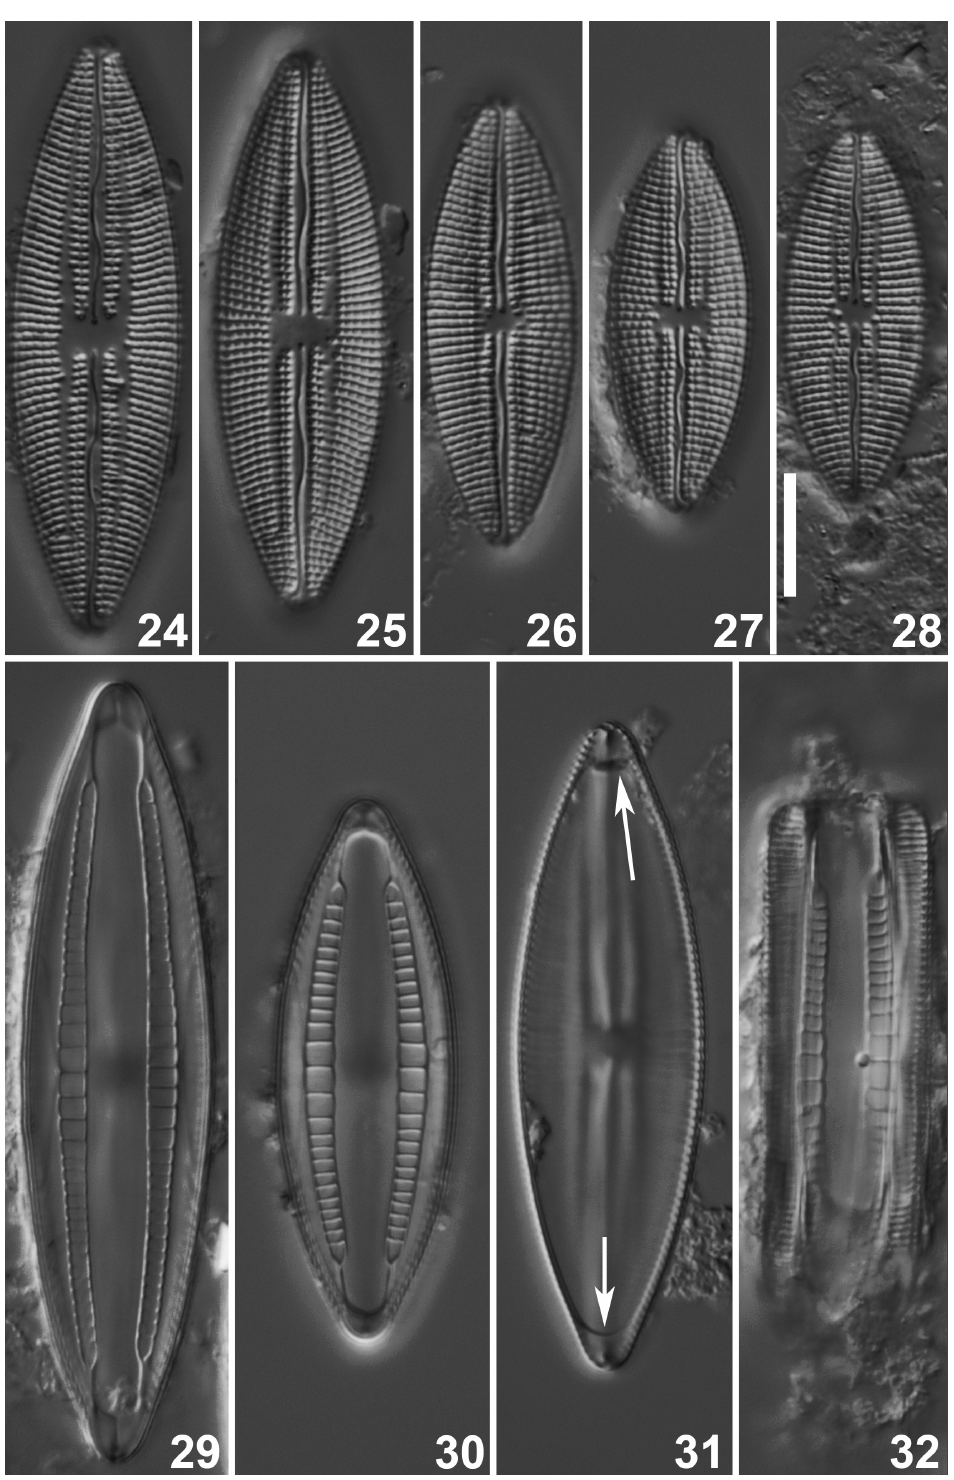
Figs 24–32. Mastogloia belaensis M.Voigt. Light micrographs (LM) of valves from the Lac de Guiers population ( Van de Vijver sample SEN-42 ). 24–28 . LM views of several smaller valves showing variation in valve size and shape. 29–30 . LM views of the partectal ring with the partecta. 31 . LM view of an entire valve with removed partectal ring showing the pseudosepta (arrows). 32 . Entire frustule in girdle view. Scale bar: 10